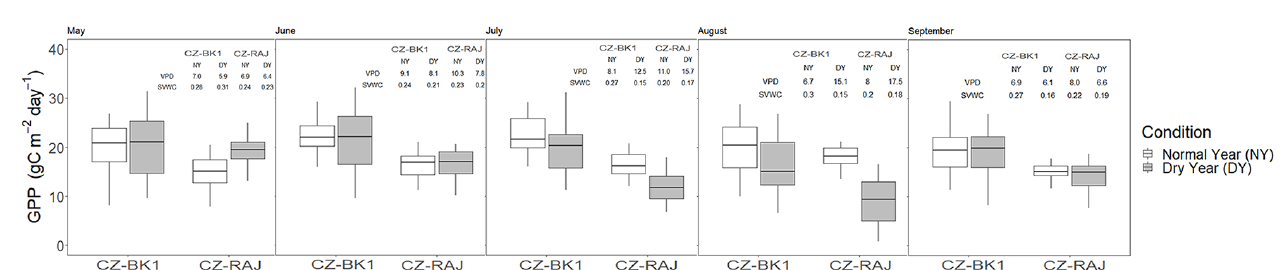
Figure 5. Monthly averages of daily sums of gross primary productivity (GPP) for May–September of the normal years (NY) and dry year (DY) in CZ-BK1 and CZ-RAJ. The tables within the figure represent the mean monthly vapour pressure deficit (VPD) and soil volumetric water content (SVWC) values from May to September for each forest station.